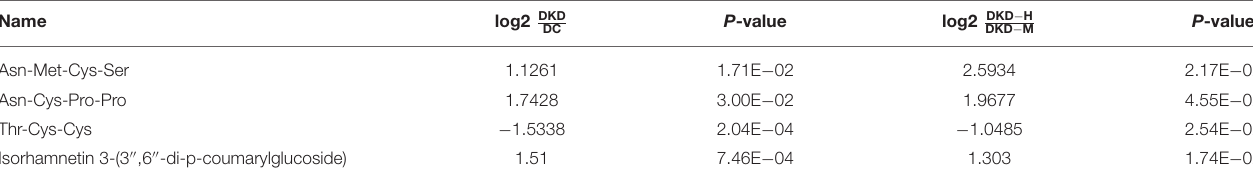
TABLE 2 | Four metabolites in the same direction after successive